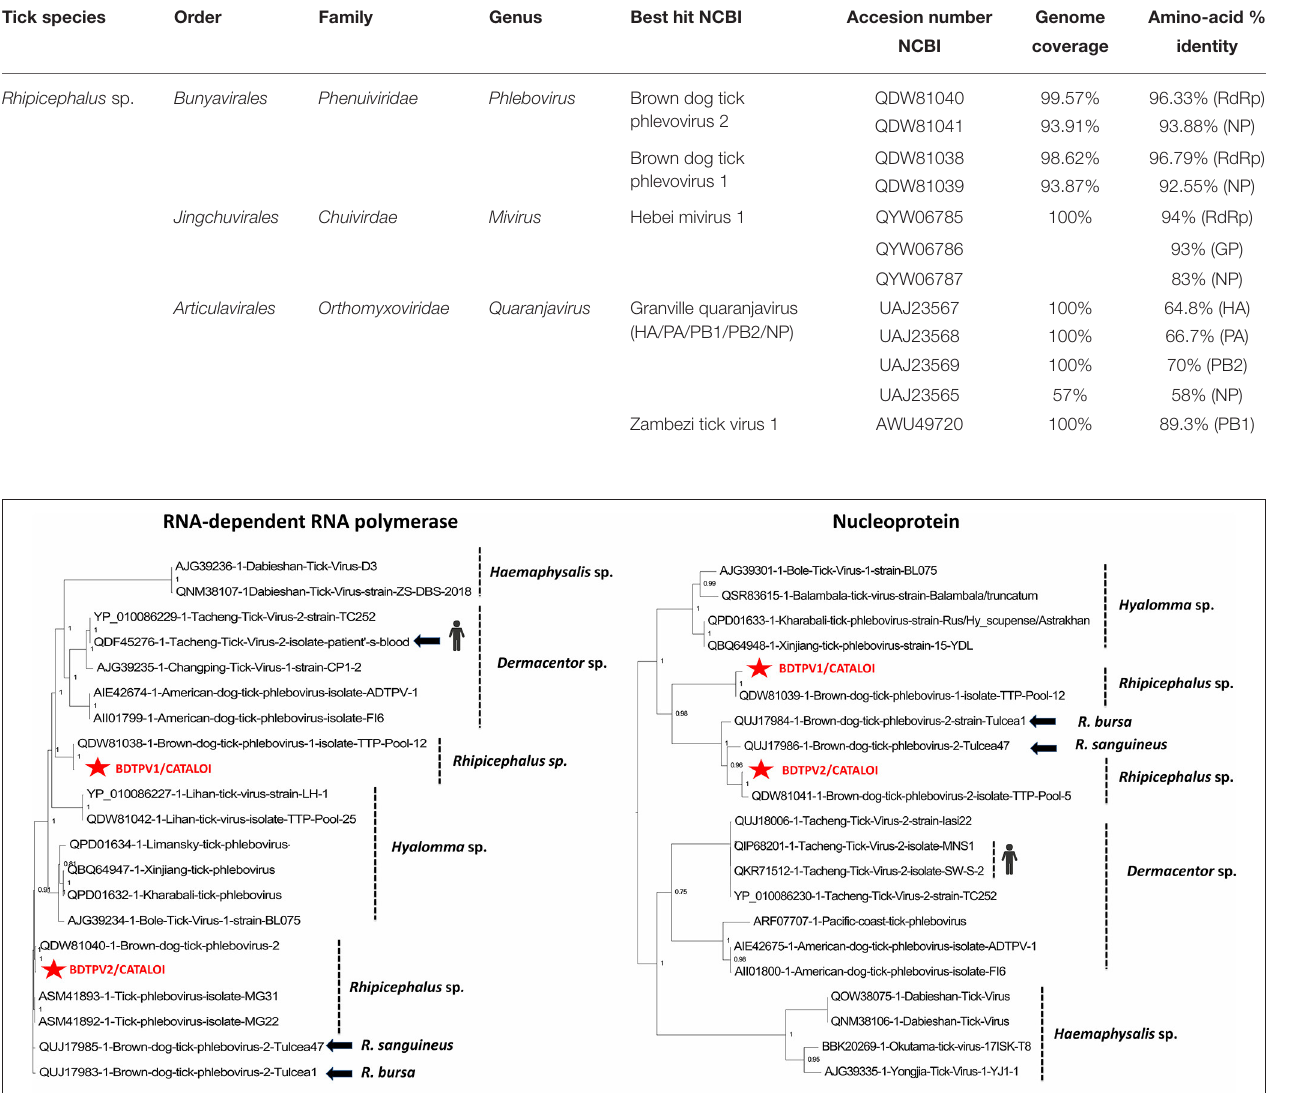
conserved of the orthomyxovirus genes) shared 89% amino-acids identity to Zambezi tick virus 1 (ZaTV-1), a highly